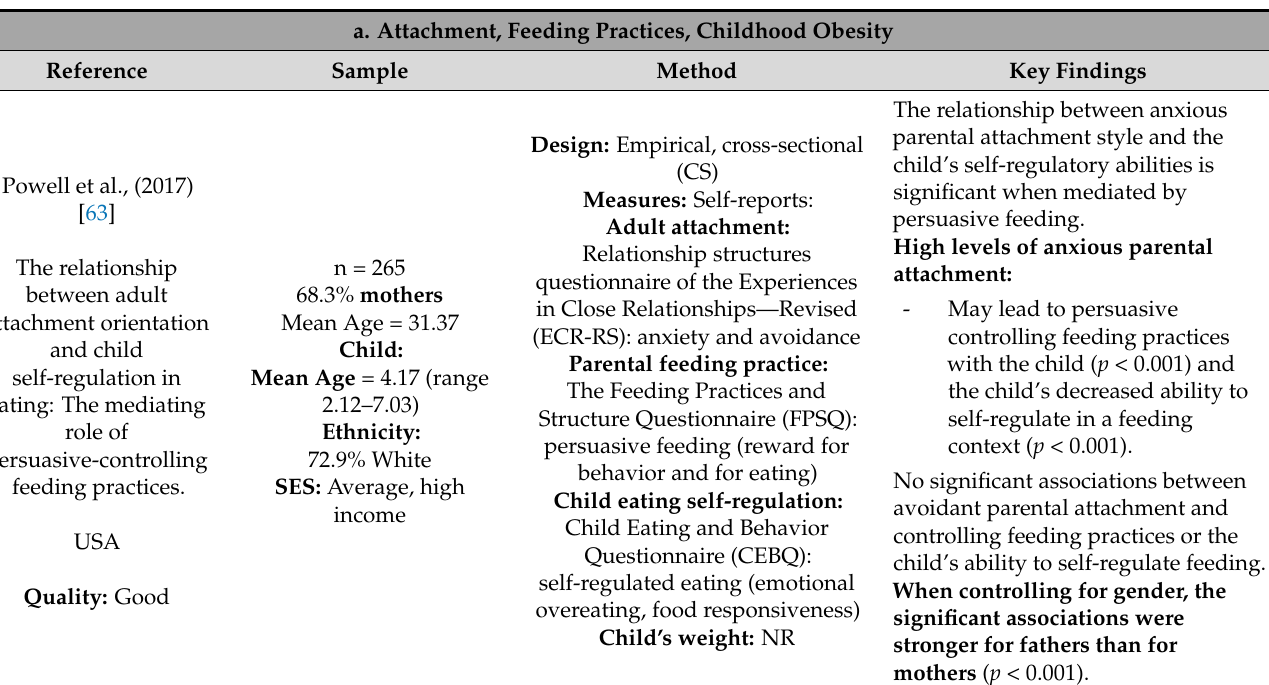
Table 3. Studies focused on the second developmental period (2–8 years).